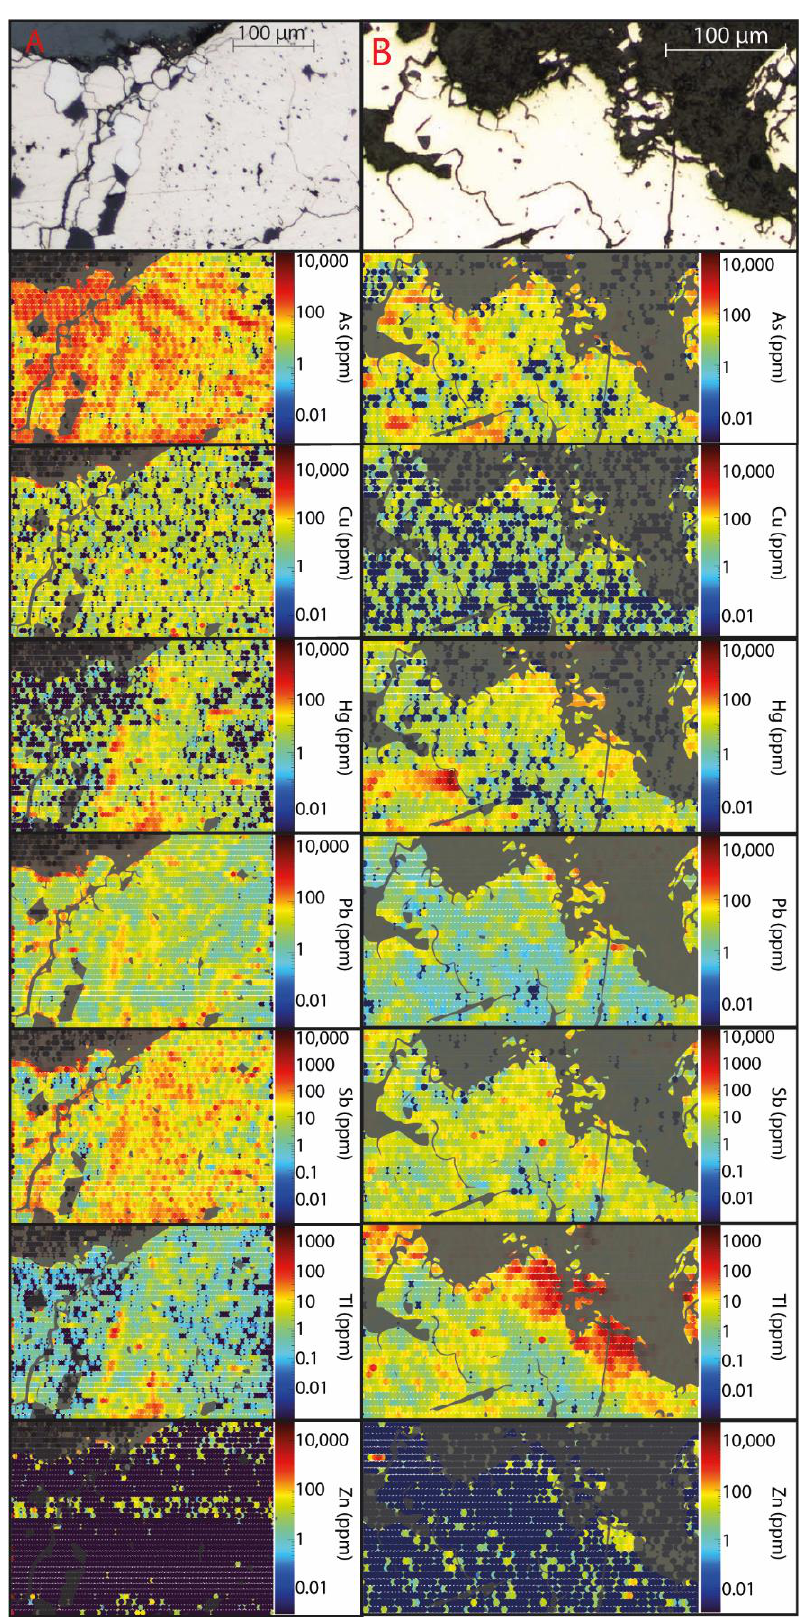
Figure 7. Quantified LA-ICP-MS element distribution maps of an area of pyrite grains in the initial sulfidic waste rock ( A ) and after 103 weeks of leaching ( B ) showing the spatial distribution of As, Cu, Hg, Pb, Sb, Tl, and Zn. Non-pyrite minerals are shaded.